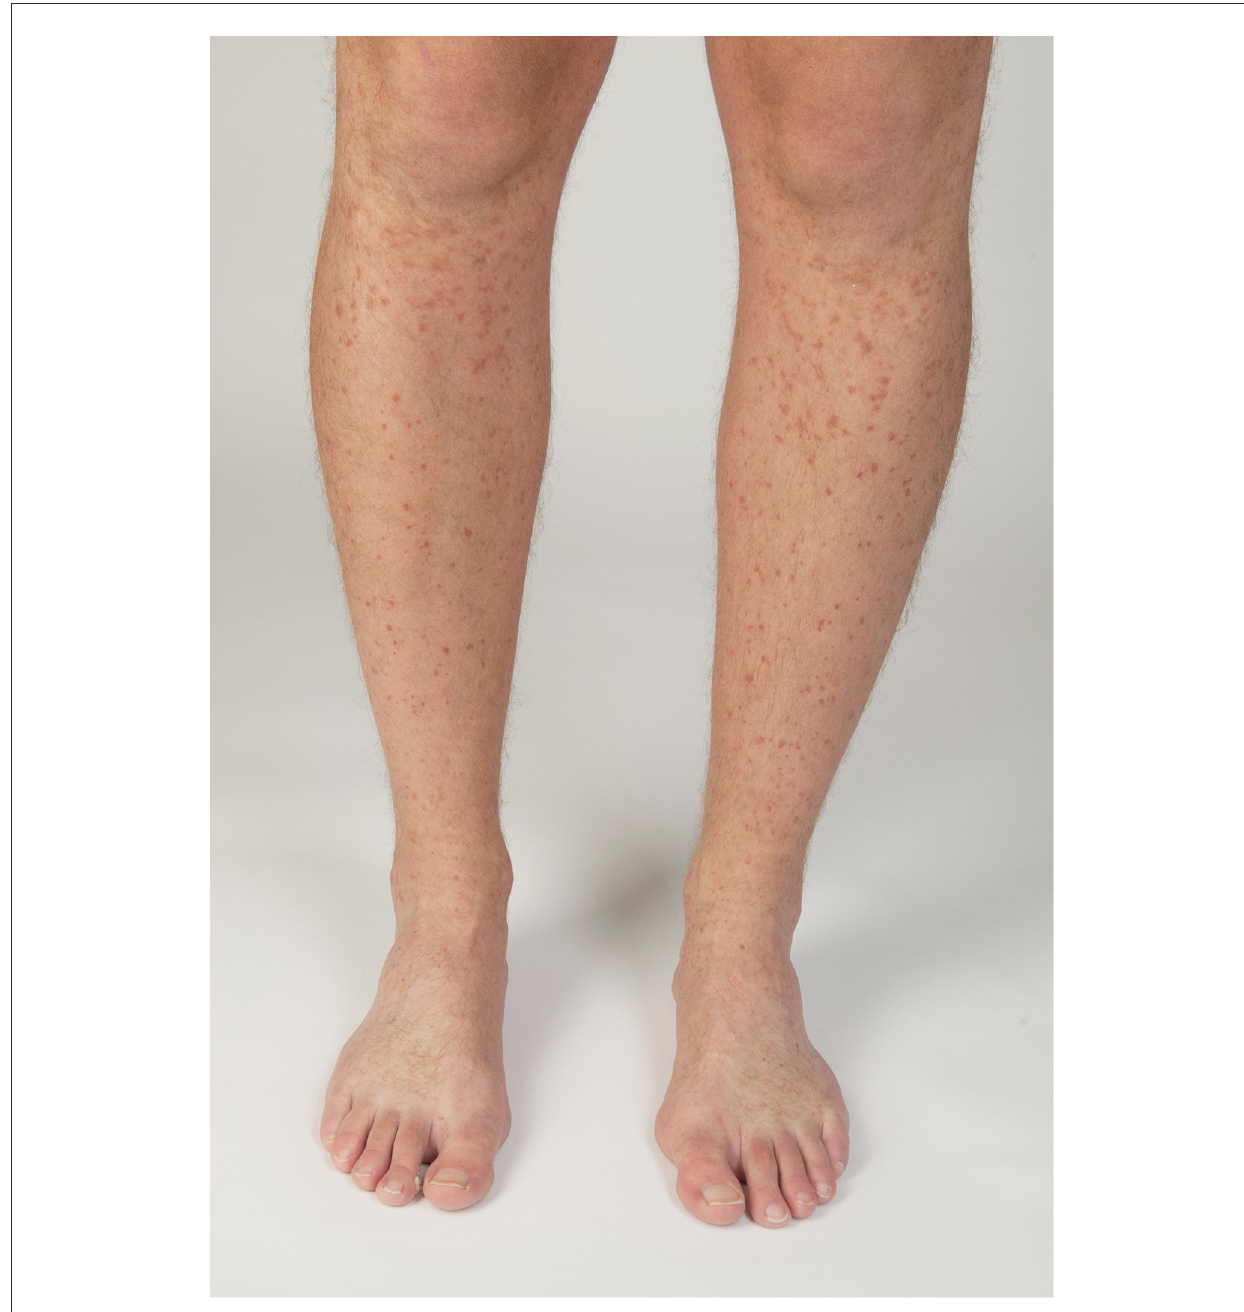
FIGURE3 Recurrent macular vasculitis associated with hypergammaglobulinemia and induced by exertion.